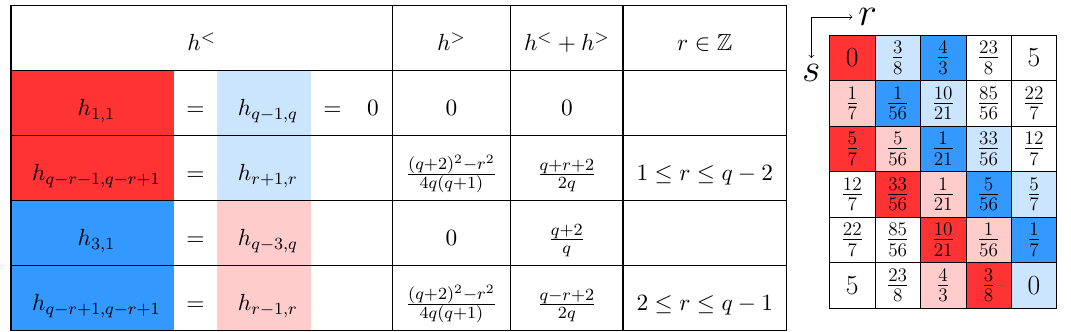
Table 2 . Special Neveu-Schwarz primaries in SW ^ c concerns only q (cid:21) 4.) As a visual guide, we also coloured the corresponding cells in the Kac table for q =